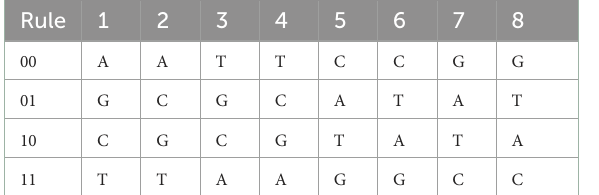
TABLE 2 DNA encoding/decoding rules.